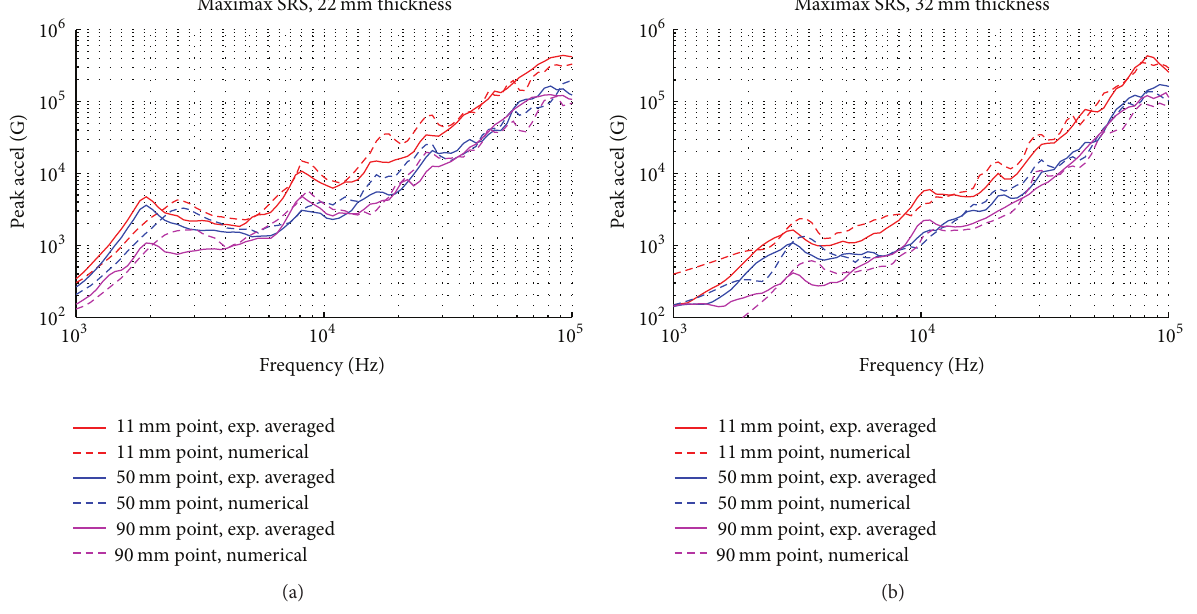
Figure 13: Comparison of maximax SRS between the numerical and averaged experimental results: (a) at a 22 mm thickness circular plate and (b) at a 22 mm thickness circular plate.